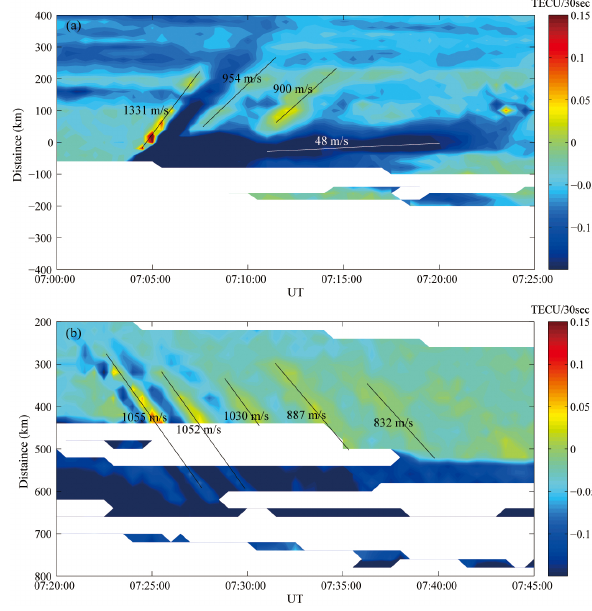
Figure 5. The rTEC time–distance velocity diagram (a) calculated from the center of the rectangle indicated in Fig. 1g (positive dis- tance indicates eastward propagation) from 07:00:00–07:25:00UT (16:00:00–16:25:00LT) for the 2013 SK event; (b) velocity diagram of delayed waves along the bow wave direction calculated from the upper short side of the rectangle indicated in Fig. 1k (positive dis- tance indicates southeastward